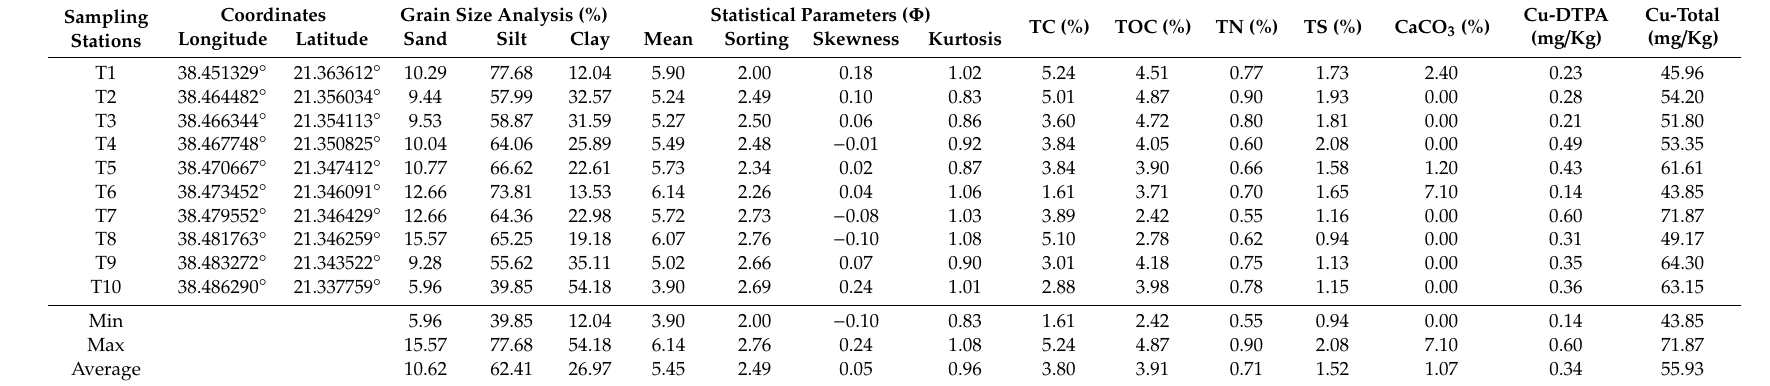
Table 2. Sedimentological and geochemical analyses of the Aetoliko lagoon sediment